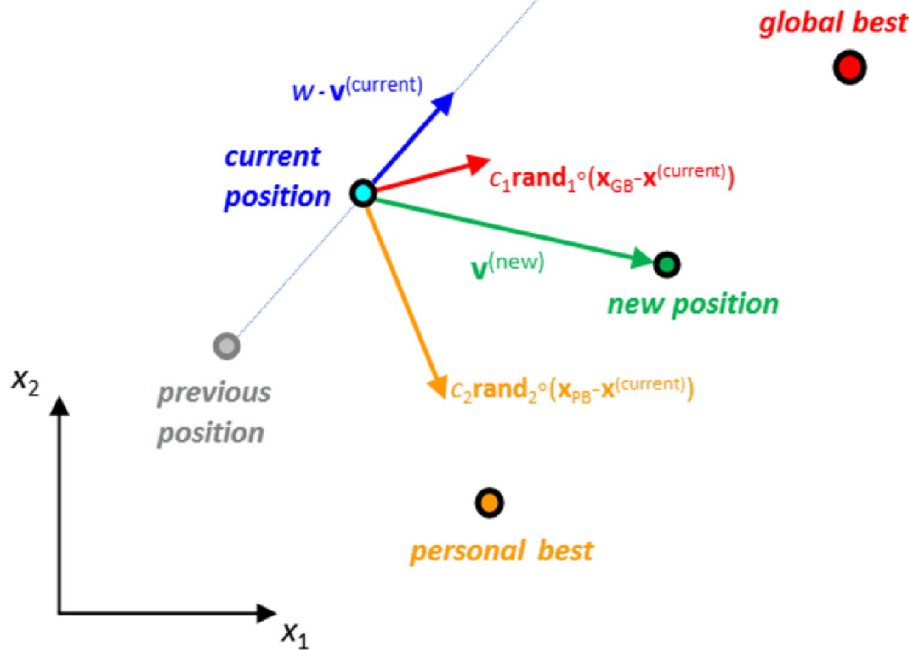
Fig 3. Schematic representation of PSO velocity